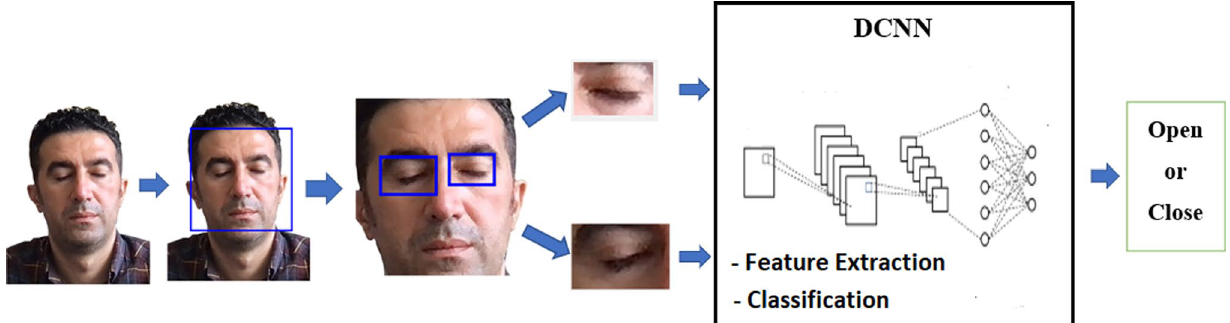
Fig. 5 Flowchart of eye state recognition application in real-world